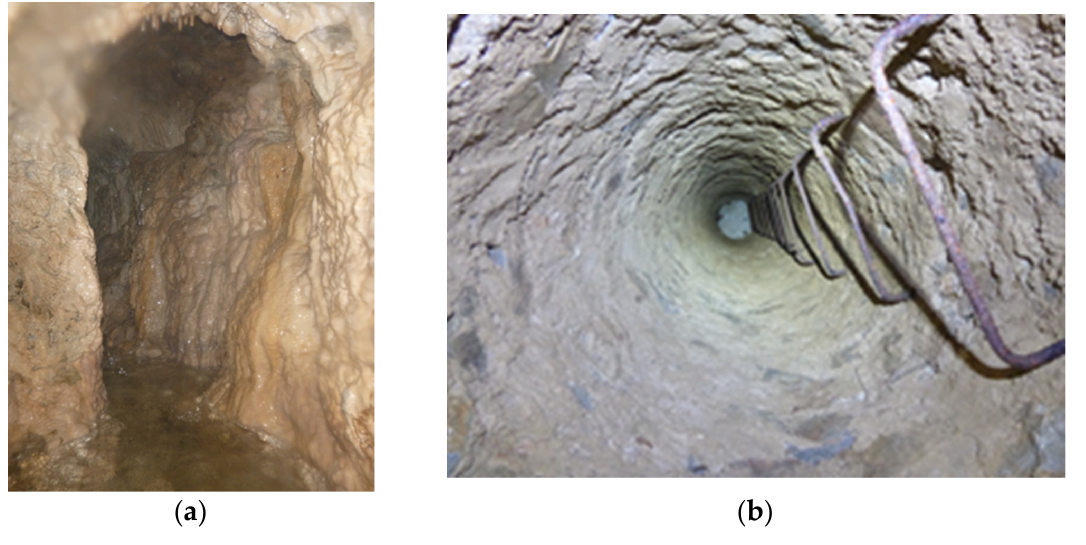
Figure 17. ( a ) Tunnel of the so-called Peisistratean (Hymettus) aqueduct. ( b ) Well of the so-called Peisistratean (Hymettus) aqueduct.